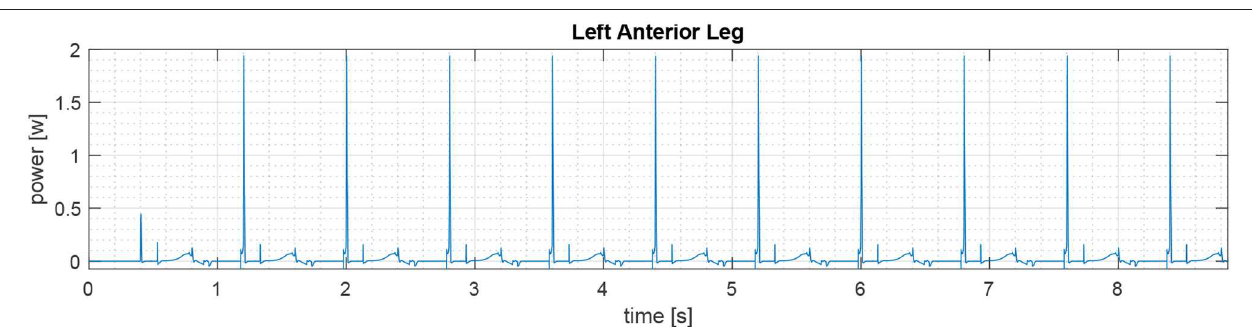
FIGURE 10 | Legs anterior power, TEST